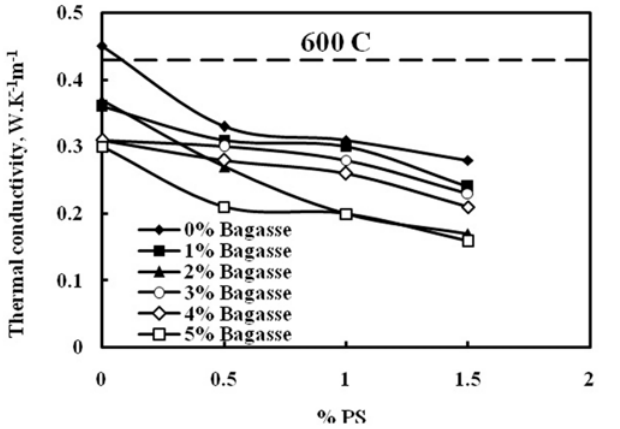
Figure 14. Effect of percent PS and Bagasse addition on thermal conductivity at 600 o C